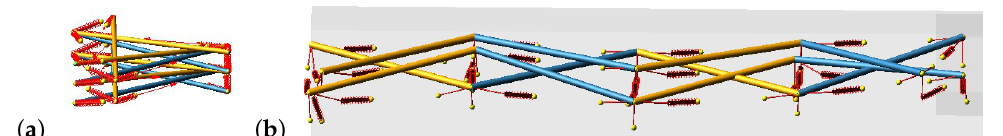
Figure 9. The simplex column deployment: ( a ) The first deployment scheme. ( b ) The second deployment